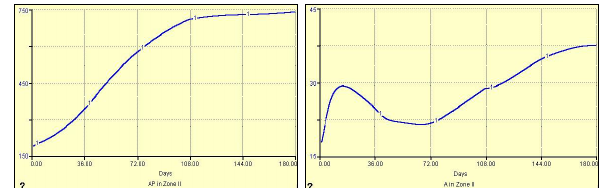
Fig. 21. Simulation results of the main ecological indexes at zone II